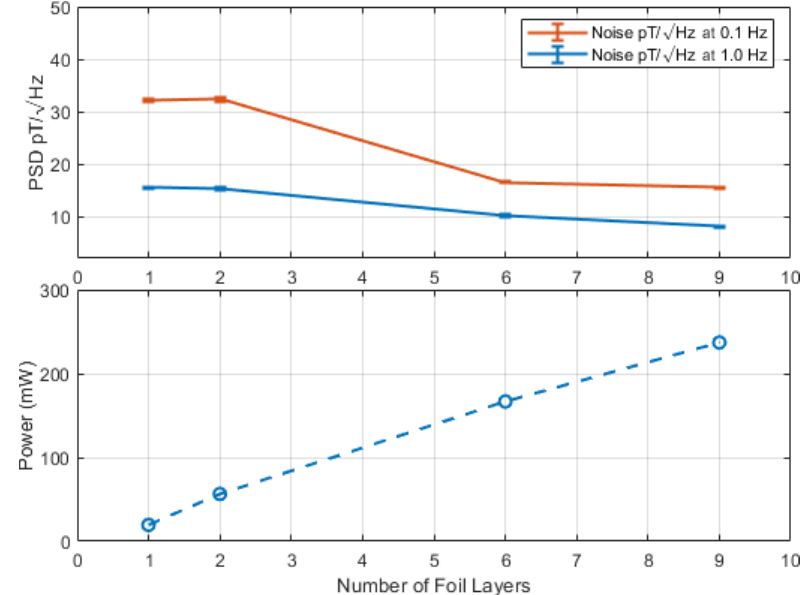
Figure 13. Magnetic noise and power consumption as a function of number of foil